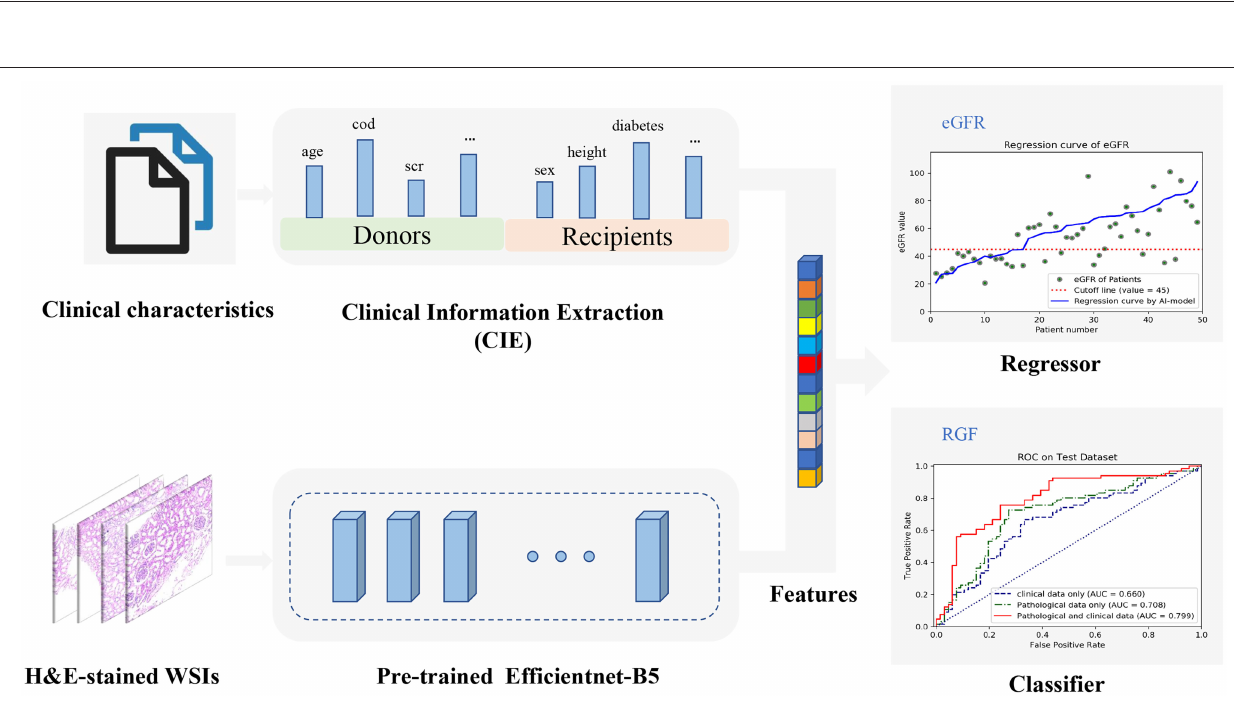
Frontiers in Medicine |